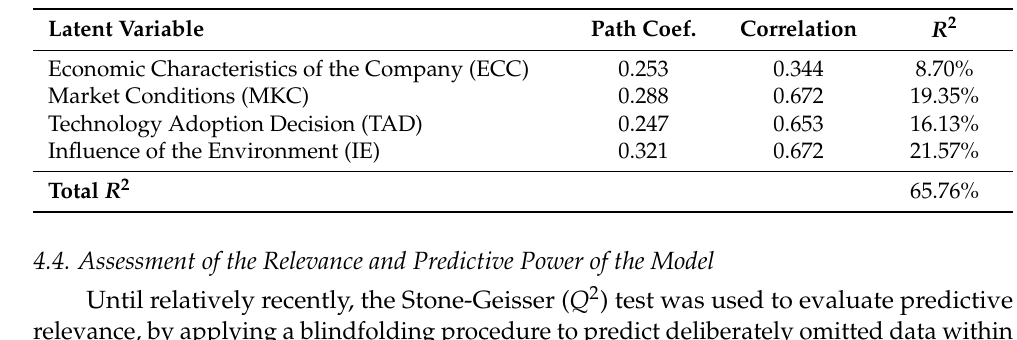
Table 13. Decomposition of the explained variance of the endogenous latent variable